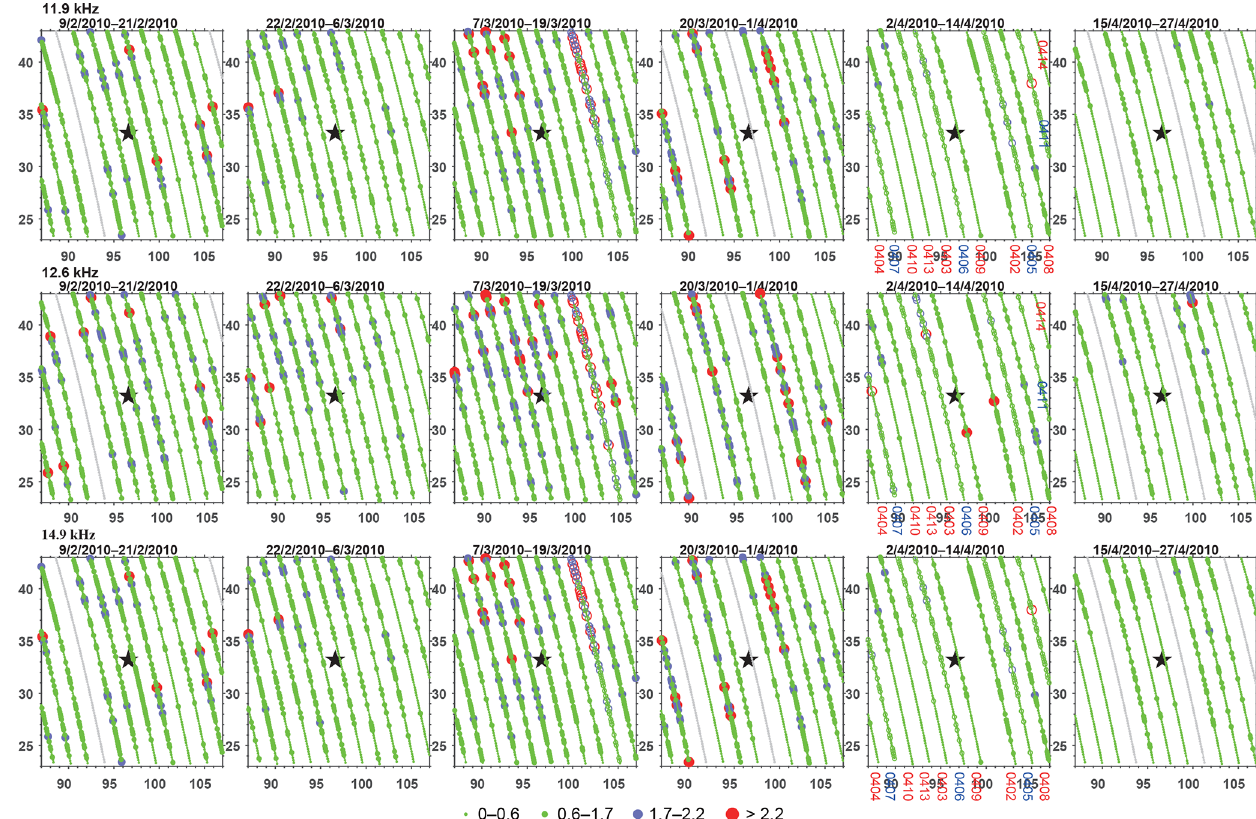
Figure 2. The evolution of SNR evolution VLF radio waves frequencies 11.9kHz (top panel), 12.6kHz (middle panel), 14.9kHz (bottom panel) with (cid:49)f = 300Hz at nighttime. The black star stands for the epicenter of the Yushu earthquake; the gray line represents the transmitter that turns off on that day; the days with high geomagnetic activity are marked by blue and hollow dots. Please note that the date format of the black text in this figure is day-month-year, but the date format of the red and blue text is month